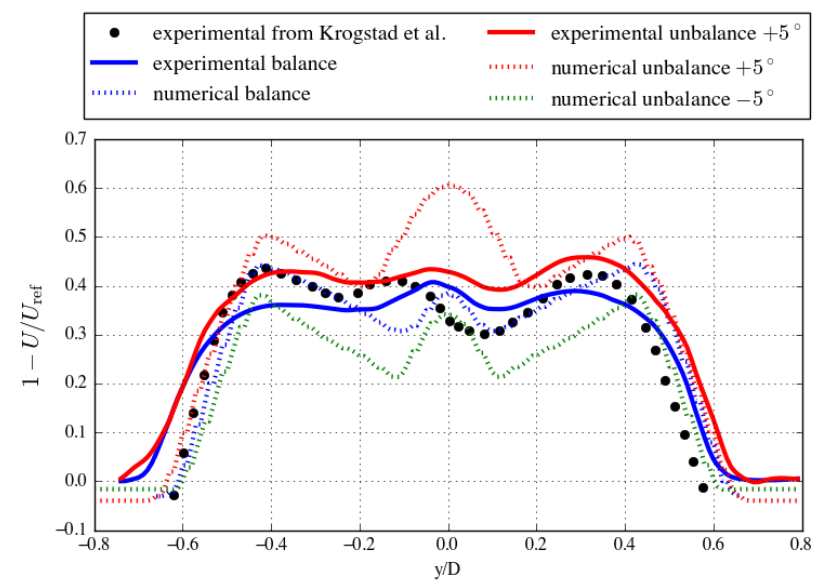
Figure 12. Numerical and experimental profiles of the normalised velocity deficit at hub height for the balanced and unbalanced cases at x / D = 3. See Figure 11 for the list of